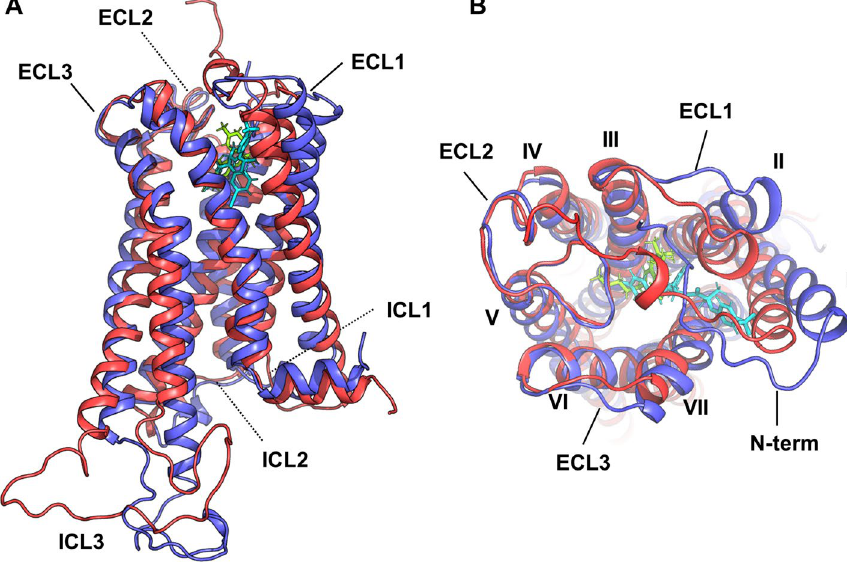
Figure 1. Overall structures of CB1 receptors. Structure of CB1 ( A ) in side view and ( B ) in top view. Colored as: active (red), inactive (blue) of CB1, agonist THC (green) and inverse agonist taranabant (cyan),